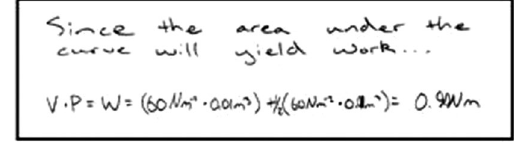
FIG. 22. Solvevaluefromgraphicalrepresentation(question10).